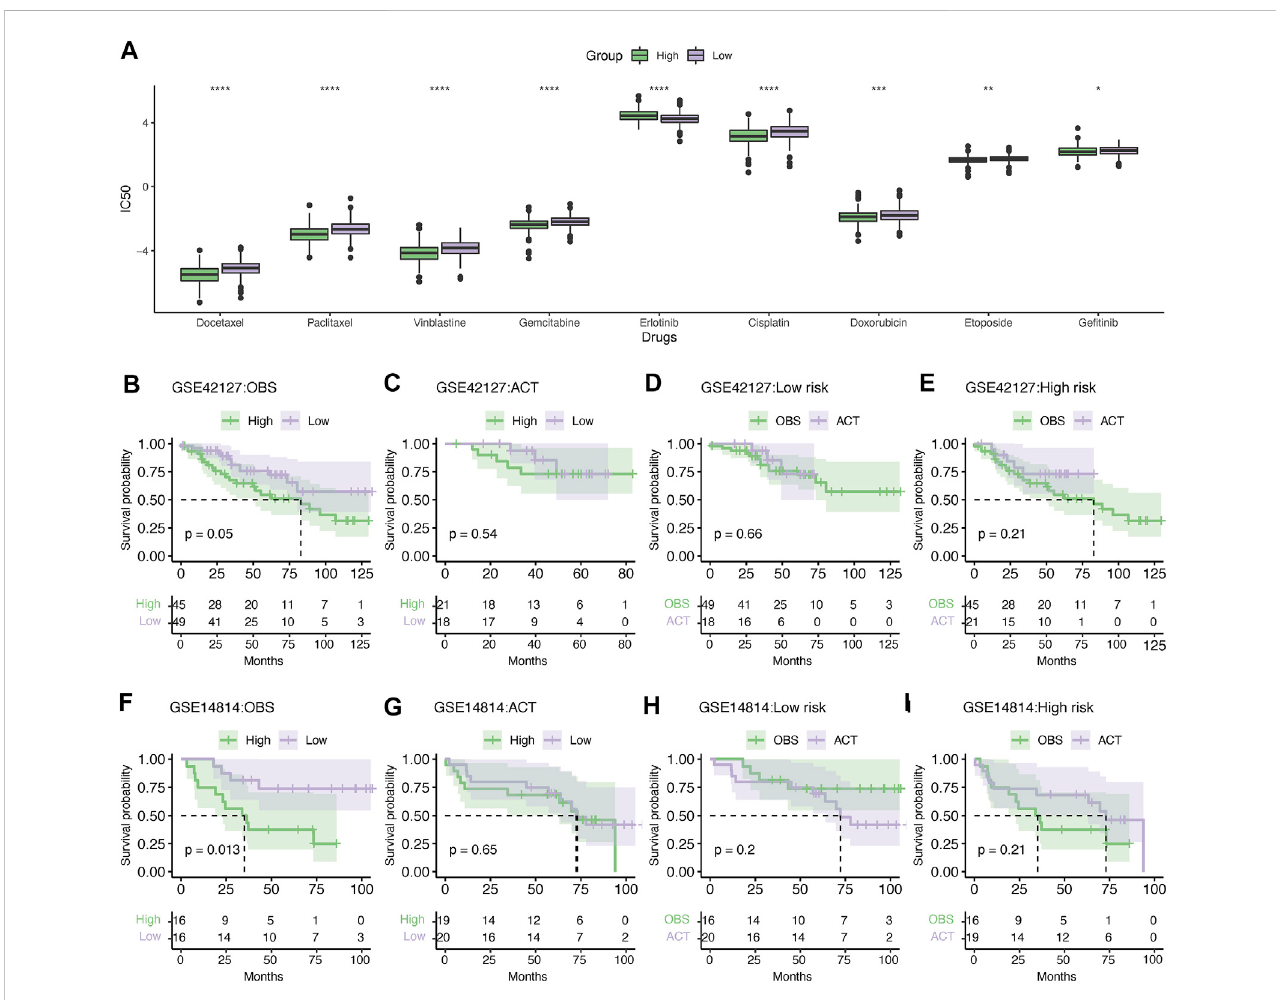
FIGURE 11 Evaluation of chemotherapy response. (A) Differences in the sensitivity of chemotherapy between high- and low-risk patients. * p < .05, ** p < .01, *** p < .001, and **** p < .0001. Kaplan – Meier survival analysis of the LUAD patients administered without (B) or with (C) adjuvant chemotherapy in the GSE42127 dataset. Kaplan – Meier survival analysis showing the survival difference in the low- (D) and high-risk groups (E) treated with or without ACT in the GSE42127dataset. Similarly,Kaplan – Meiersurvivalanalysisshowingthedifferenceinsurvivalbetweenthehigh-andlow-riskpatientswithout (F) orwith ACT (G) in the GSE14814 dataset. Kaplan – Meier survival analysis of low- (H) or high-risk patients (I) treated with ACT or observation alone. IC50, the half maximal inhibitory concentration; ACT, adjuvant chemotherapy; and OBS,